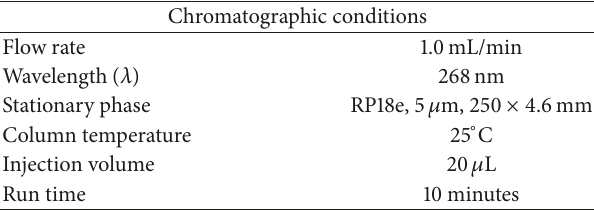
Table 1: HPLC chromatographic conditions of the current method. Table 2: Stress conditions applied for drug substance and drug